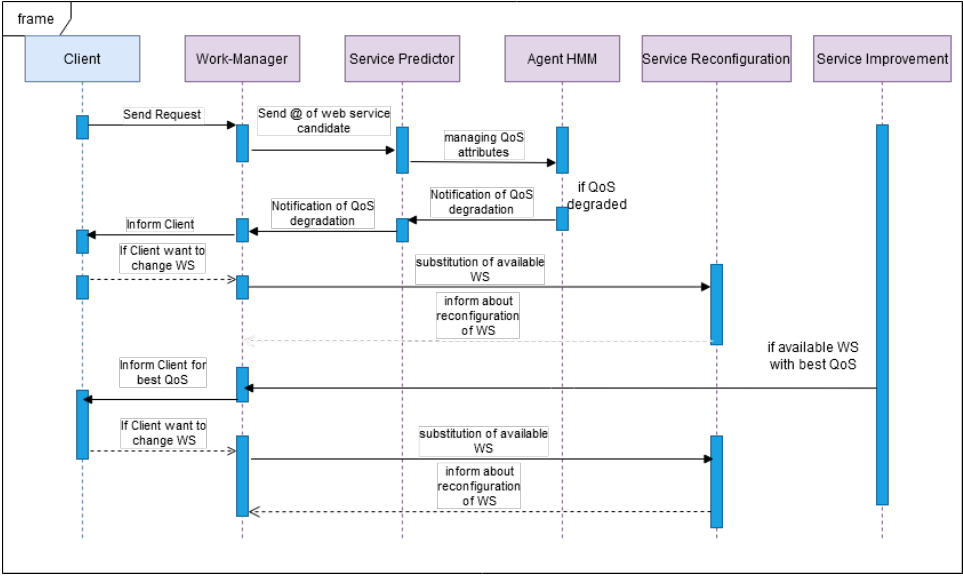
Figure 2. Framework execution